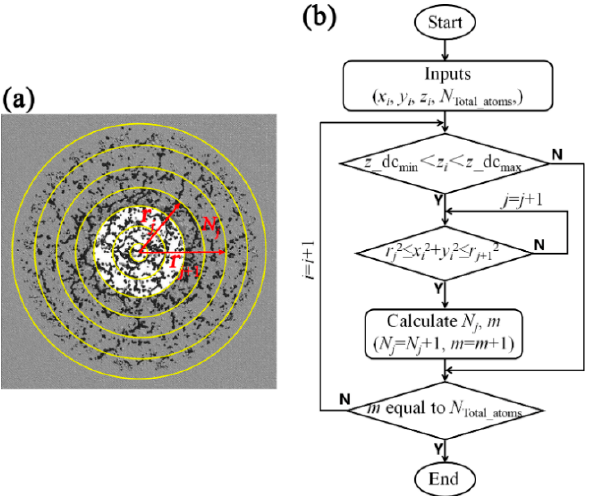
Figure 8. Schematic diagram ( a ) and flow chart ( b ) of the algorithm for solving the radial distribution of debris particles.